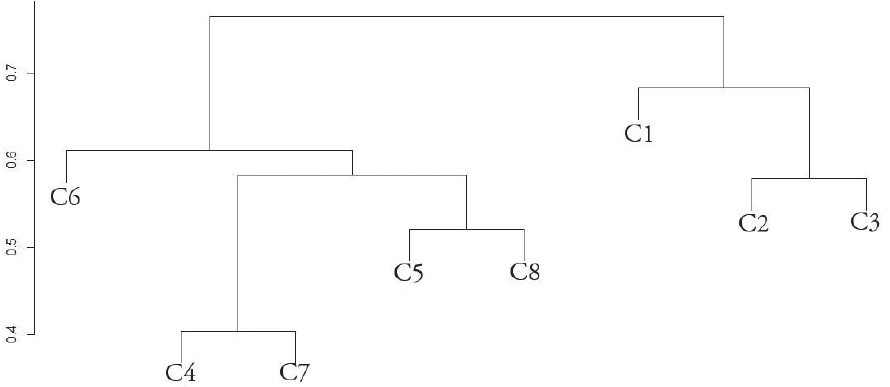
Figure 6. Cluster analysis of spontaneous species used in the eight districts of Puglia C1 Gargano C2 Ta- voliere delle Puglie C3 Monti Dauni C4 Terra di Bari Murgiana C5 Terra di Bari premurgiana C6 Valle d’Itria C7 Salento C8 Arco ionico